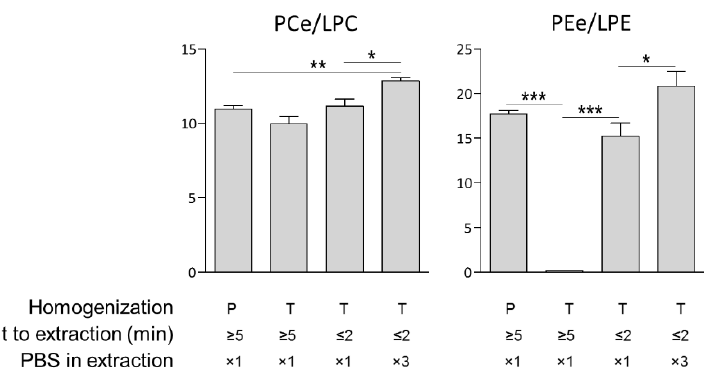
Figure 2. Proportions between major ether-containing phospholipids and their lyso-derivatives. Homogenization was performed in PBS (P) or Trizol (T), time between lipid extraction and homogenization was kept under 2 min or not and buffering of the lipid extraction mixture with PBS was variable (see Materials and Methods section). Data correspond to n = 5 and are shown as the mean ± SEM. Student’s t -test: * p < 0.05; ** p < 0.01; *** p < 0.001.